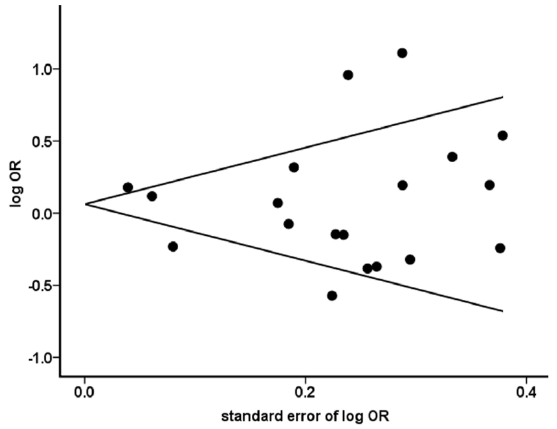
Figure 2. Begg’s funnel plot for publication bias on the association between TNF- α -308G>A polymorphism and NHL risk in additive